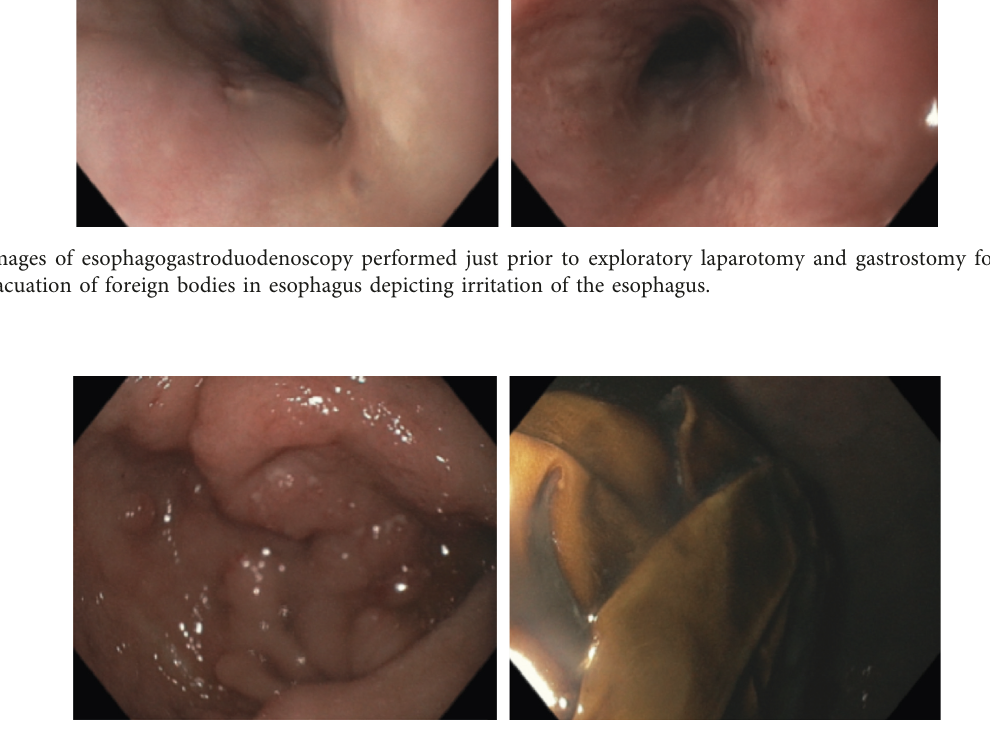
Figure 2: Esophagogastroduodenoscopy images of the antrum of the stomach depicting gastric hyperplasia and gastric bezoar composed of